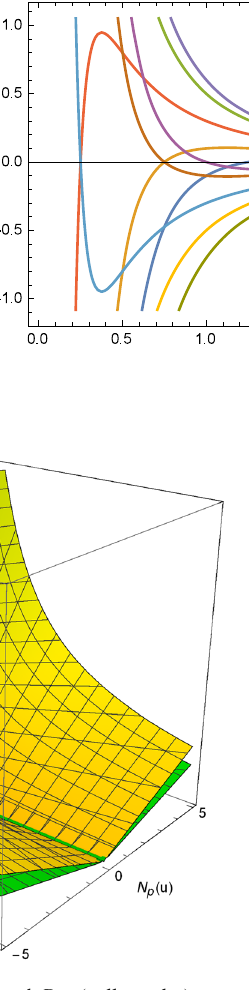
(yellow plot) ver- 2